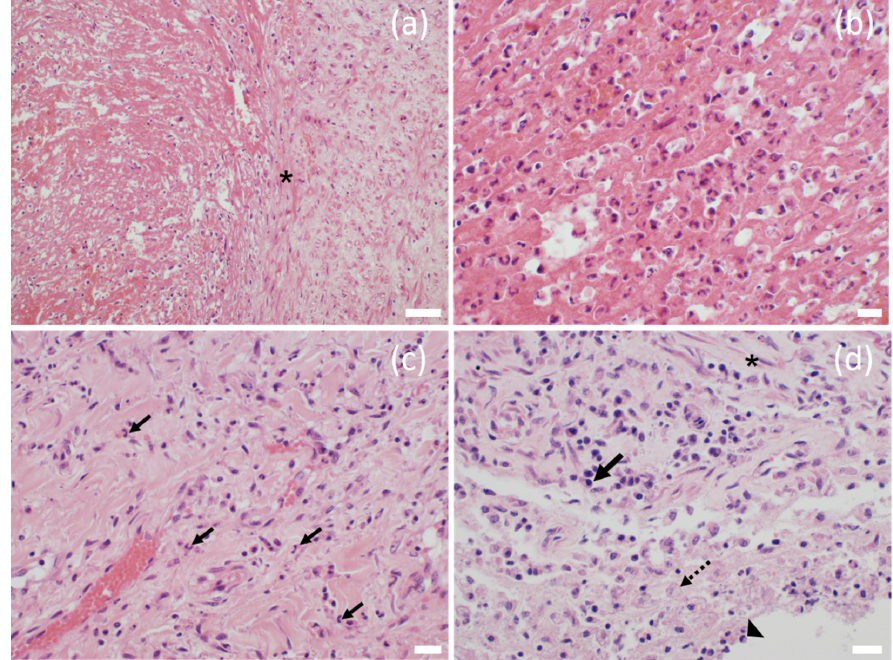
Figure 2. ( a ) Thrombotic artery. Thrombotic fibrin was firmly attached to the remnant of the vascular wall. The vascular wall did not present a regular histological architecture lacking the endothelial cells and showing only residues of smooth muscle cells (asterisk). HE 200× g magnification; bar = 50 μ m. ( b ) Occasionally, the thrombotic fibrin was admixed with erythrocytes and neutrophils; how- ever, no bacteria were visible. HE 400× g magnification; bar = 20 μ m. ( c ) Surrounding tissue of throm- bosed vessel showed a granulation tissue with perpendicularly aligned neovascularization admixed with chronic-active inflammatory infiltrates, predominantly characterized by neutrophilic granulo- cytes (arrows), HE 400× g magnification; bar = 20 μ m. ( d ) Abscess capsule. The capsule was charac- terized by fibrous tissue containing fibrocytes (asterisk) admixed with a chronic immune cell infil- tration including plasma cells (black arrow). Centrally, neutrophils (arrowhead) and macrophages (dotted arrow) were present. HE 400× g magnification; bar = 20 μ m. Figure 3. Detection of streptococcus in the abscess. ( a ) Numerous streptococci (red) were identified within cells via immunofluorescence. Nuclei of cells were detected with the DNA-binding dye DAPI (blue). 600× g magnification, bar = 20 μ m. ( b ) Consecutive slide. Most of the cells were morphologi- cally identified as macrophages. HE 600× g magnification; bar = 20 μ m.